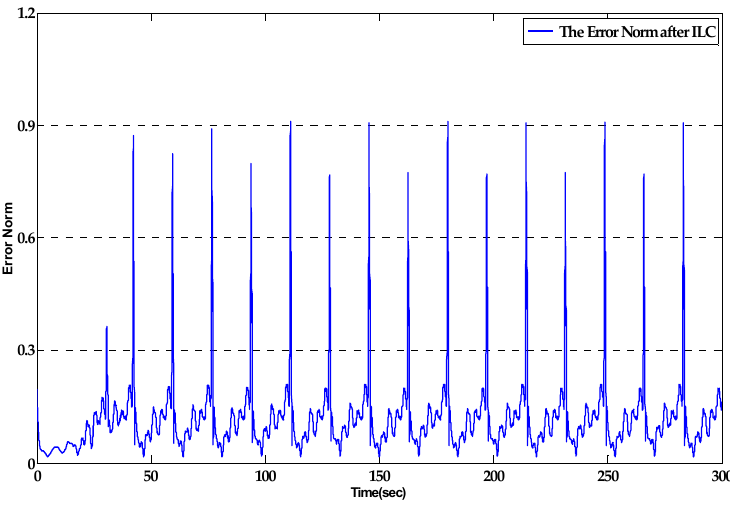
Figure 8. The cost function from the error norm after applying the ILC (iterative learning control) update law.